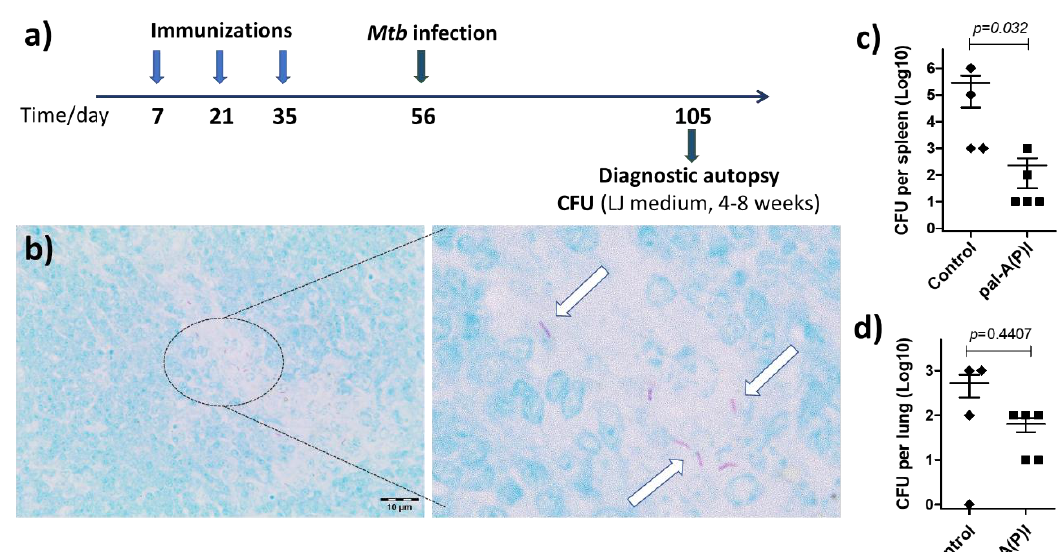
Figure 5. ( a ) Time schedule of the vaccine efficacy experiment and ( b ) experimental proof of Mycobacterium tuberculosis infection. In Ziehl–Neelsen-stained histologic sections prepared from the spleen, numerous acid-fast rod-shaped organisms were observed ((b), arrows point at Mtb cells). Magnification: 100× on the left panel, 600× on the right panel of (b). The vaccine efficacy of the pal-A(P)I conjugate was proved by enumerating a lower number of Mycobacterium tuberculosis ( Mtb ) bacteria from ( c ) spleen and ( d ) lung homogenates. Statistical significance was analyzed by Mann–Whitney U test (confidence intervals: 95%).